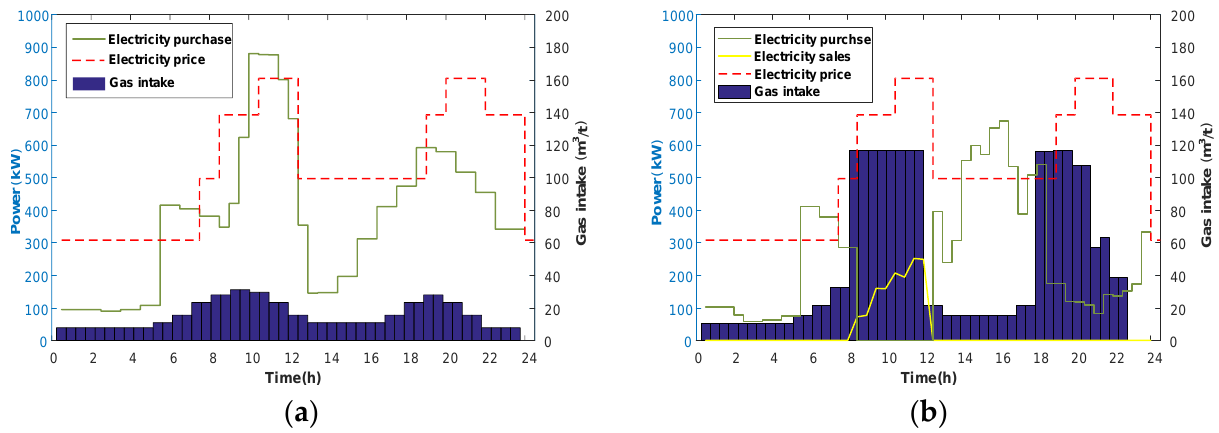
Figure 4. Natural gas and electricity purchased/sold results: ( a ) before optimization; ( b ) after optimization.